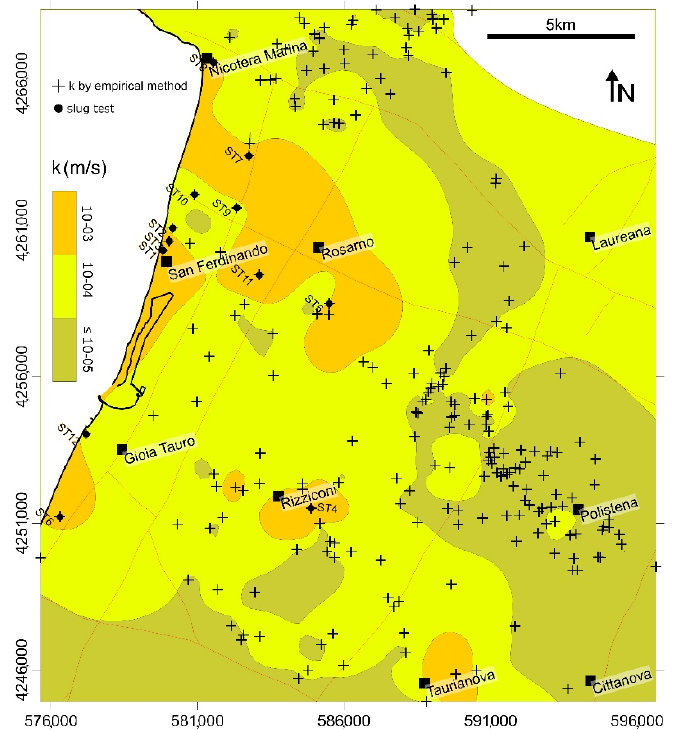
Figure 8. Distribution map of k of the HU3 based on the values obtained through the pumping test for 225 wells.